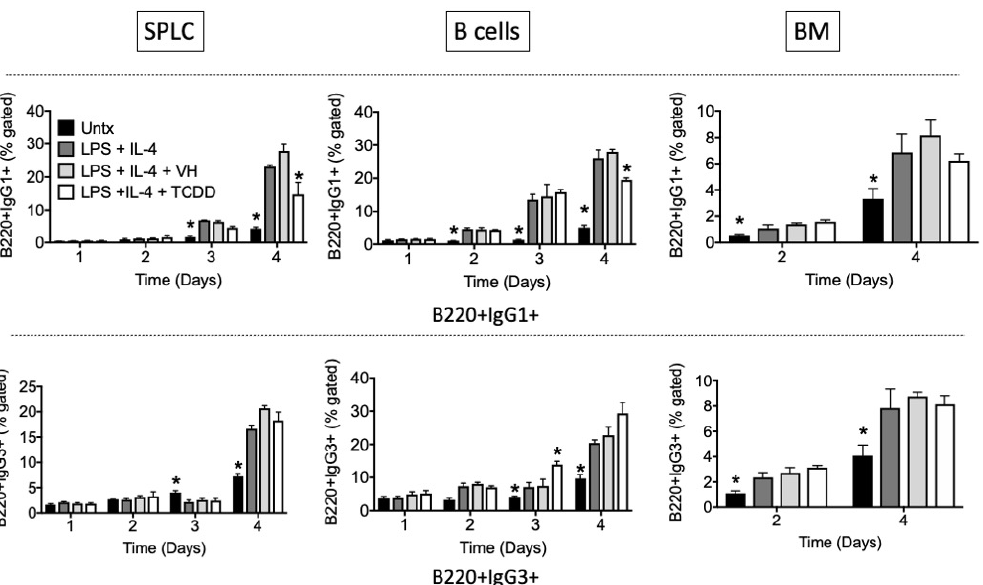
Figure 9. TCDD inhibited the percentage of B220+IgG1+ cells in SPLC and B cells at day 4. SPLC, B cells or BM cells were treated with VH (0.01% DMSO) or TCDD (30 nM) for 30 min then were stimulated with LPS + IL-4 (5 µg/mL + 10 ng/mL). Cells were incubated for 1, 2, 3 or 4 days then stained for CD19, B220, CD5, IgG1 and IgG3 (top, IgG1; bottom, IgG3; B220 shown only). Cells were gated on live single lymphocytes. Bars represent mean ± SD from triplicate samples. Untx, untreated; VH, vehicle. * p < 0.05 as compared to respective LPS + IL-4 + VH control within day. Experiments were repeated at least twice.